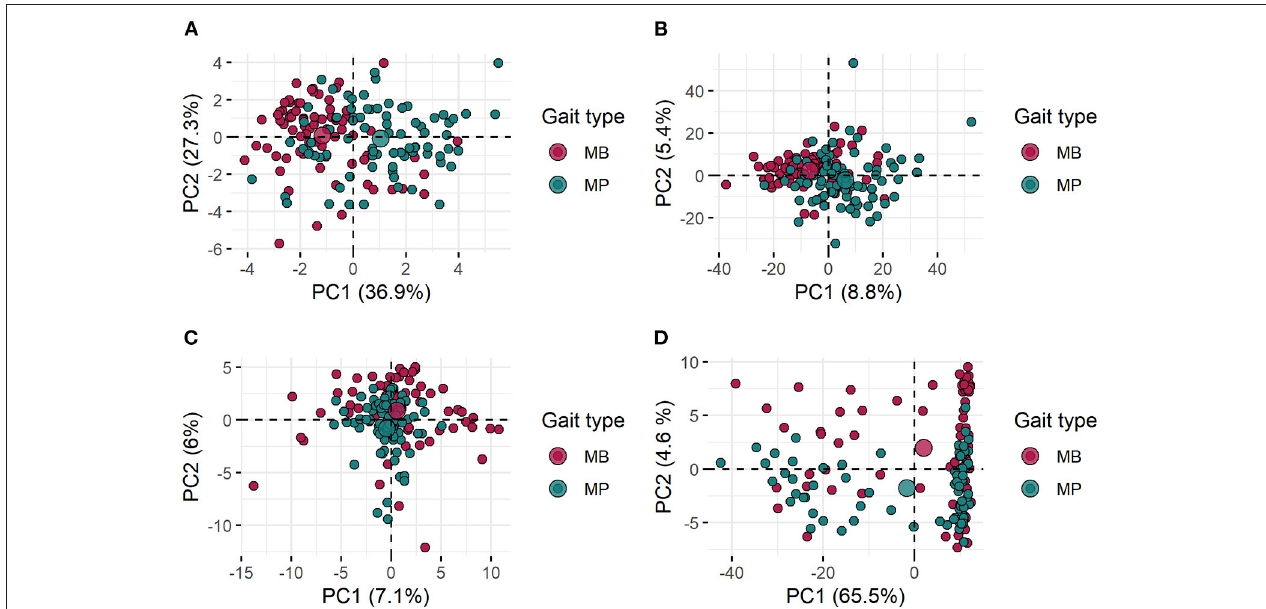
FIGURE 7 | Scatter plot for the first and second principal components (PC1 and PC2) of the initial 12 single-valued features set ( A ; please refer to Table 1 for further details) and for the different audio feature datasets ( B —Mel-frequency Cepstral Coefficients, C —Onset Strength and D —Tempogram) proposed for training the classification models. All features were extracted from audio recordings of gait types ( marcha batida— MB and marcha picada —MP) exhibited by Brazilian horses.